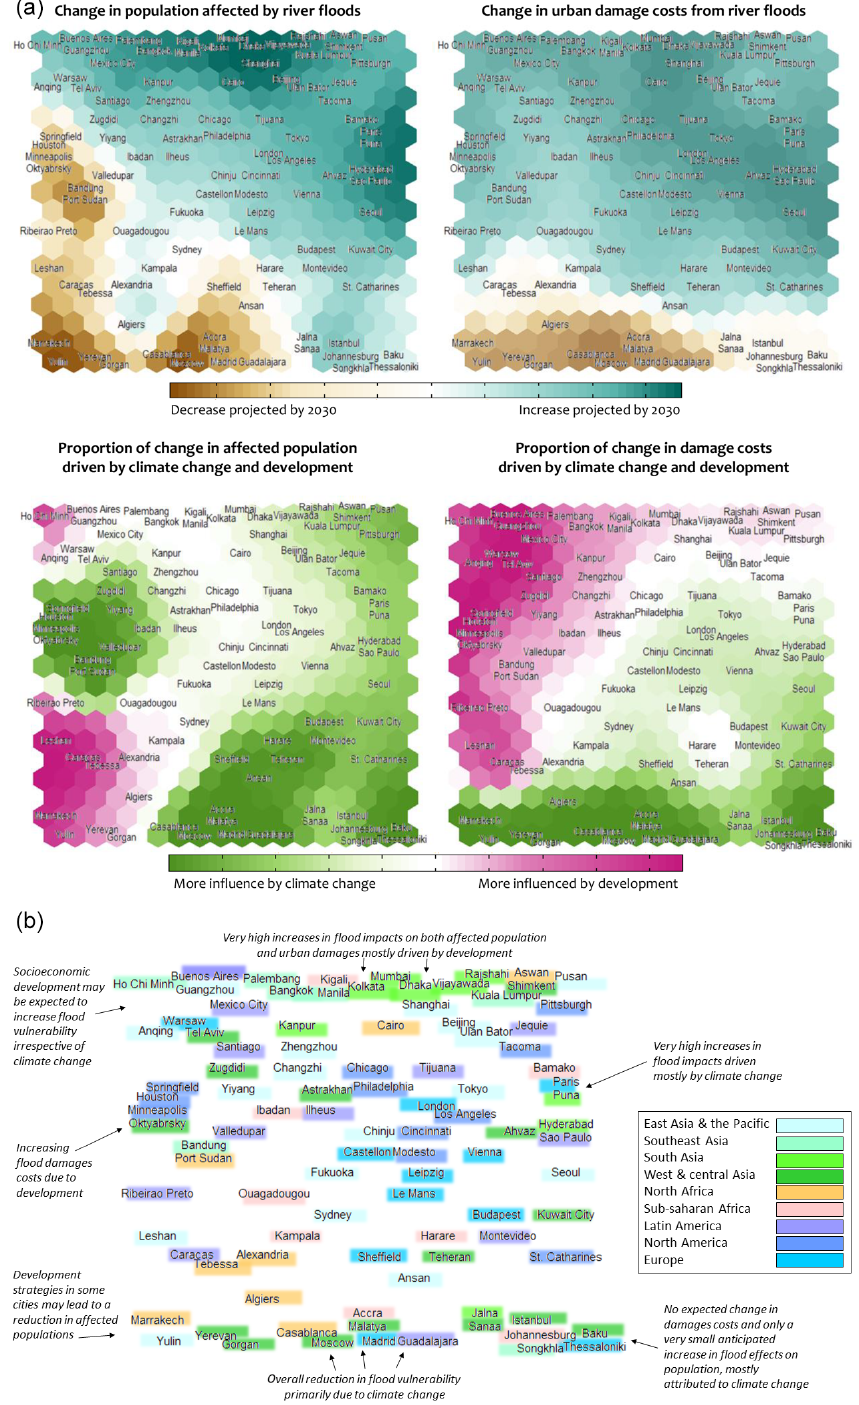
Figure 2. SOM2 – projected changes in river flood impacts with associated drivers. River flooding in individual cities will be affected separately by climate change and development between 2010 and 2030. Cities that are anticipated to experience similar pressures and responses in terms of river flooding impacts are located near eachother on the map. (a) City labels are placed over coloured copies of the map showing the relative values of each variable. (b) City labels are coloured by region, and characteristic patterns of general areas of the map are annotated. The reader may refer to the online version to zoom in on text if